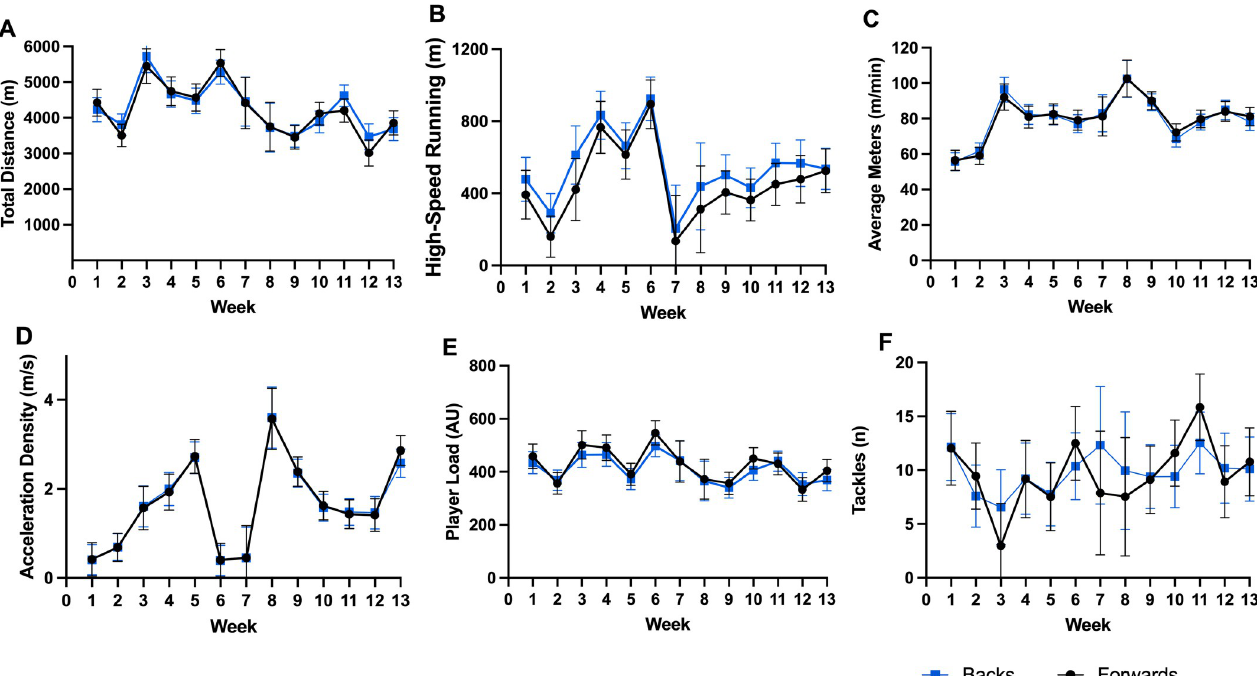
Fig 2. Mean sessional field-based external load, between positional groups, across weeks. (A) Total distance, (B) High-speed running, (C) Meters per minute average, (D) Acceleration density, (E) PlayerLoad, (F) Tackles.